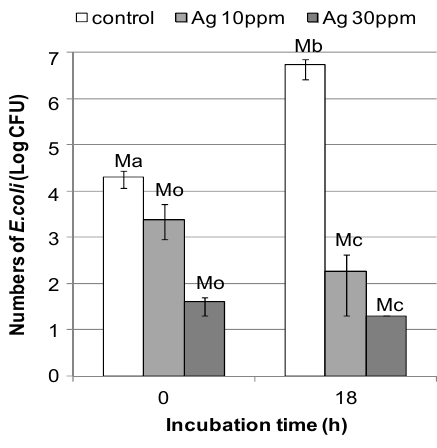
Figure 6. Numbers of colonies found for the untreated fabrics (controls) and for the DNA/Ag nanoparticles immobilized fabrics (10 and 30 ppm as Ag) at the starting point (0 h) and after 18 h incubation (18 h). If no colonies were observed, the number was regarded as less than 20 CFU/mL and was shown as 20 CFU/mL Error bars represent maximum and minimum value ( n =